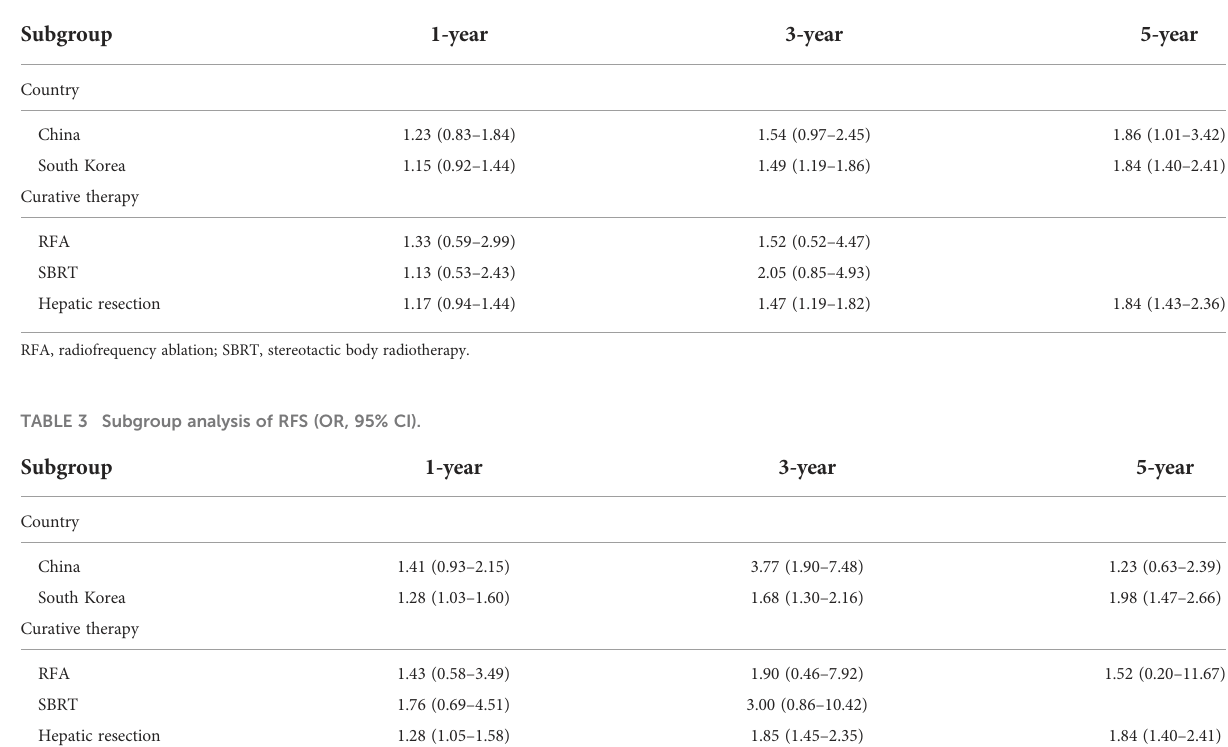
TABLE 2 Subgroup analysis of OS (OR, 95% CI) .